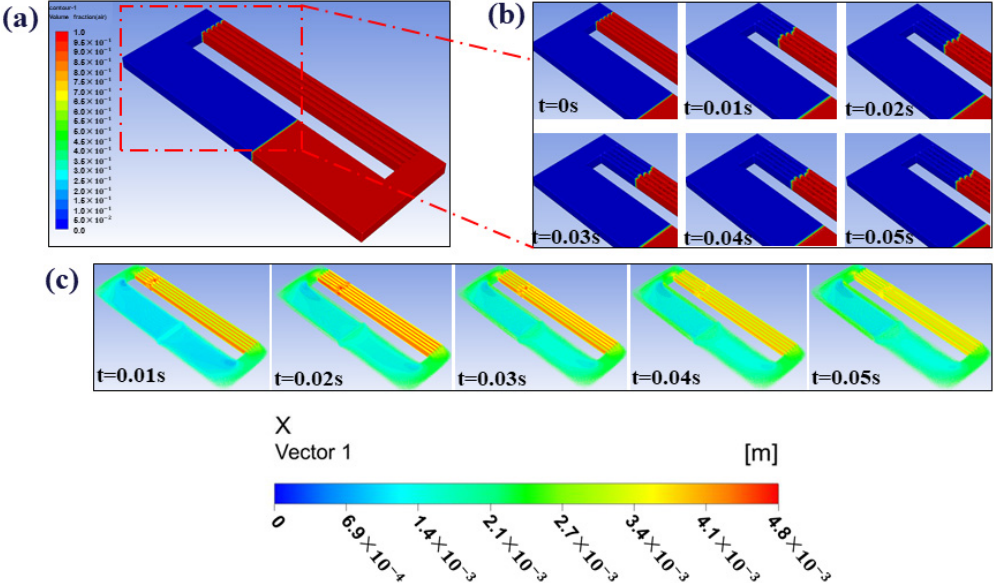
Figure 5. Analysis of simulation results. ( a ) Initial gas–liquid distribution; ( b ) Contours of transitive suction process; and ( c ) Velocity vector process